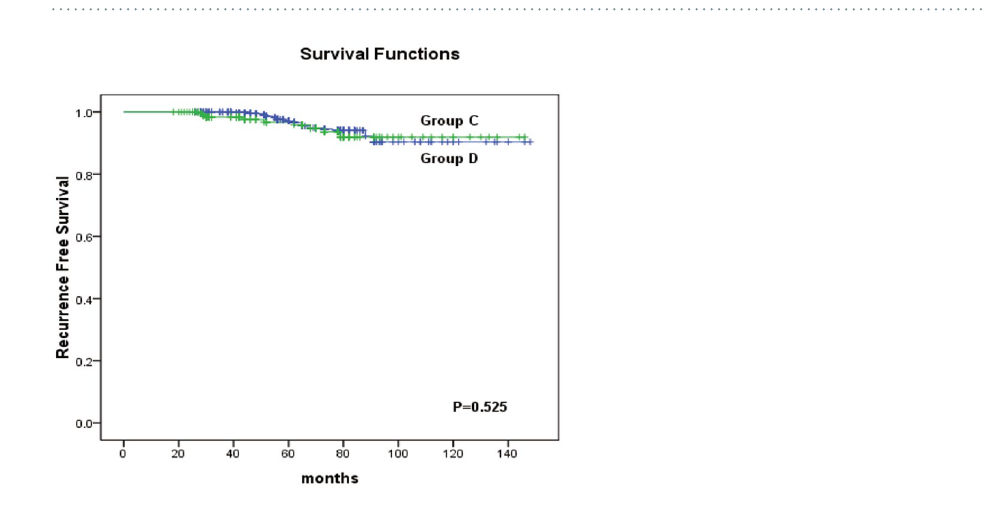
Figure 1. Kaplan-Meier analysis of recurrence-free survival of unifocal papillary thyroid cancer with a diameter > 1 cm and ≤ 2 cm (group A) and multifocal papillary thyroid microcarcinoma with a total tumour diameter (TTD) > 1 cm and ≤ 2 cm (group B).